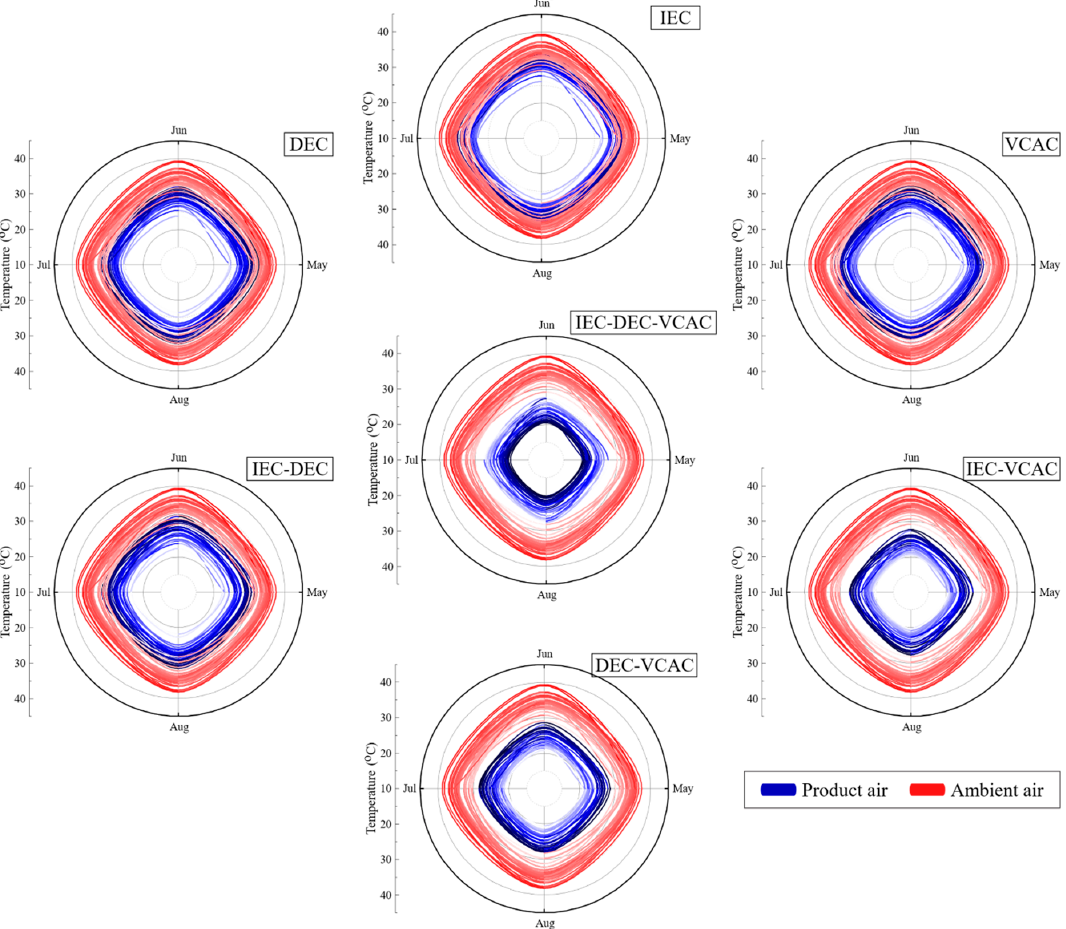
Figure 9. Profile of temperature gradient in typical summer months of Multan.